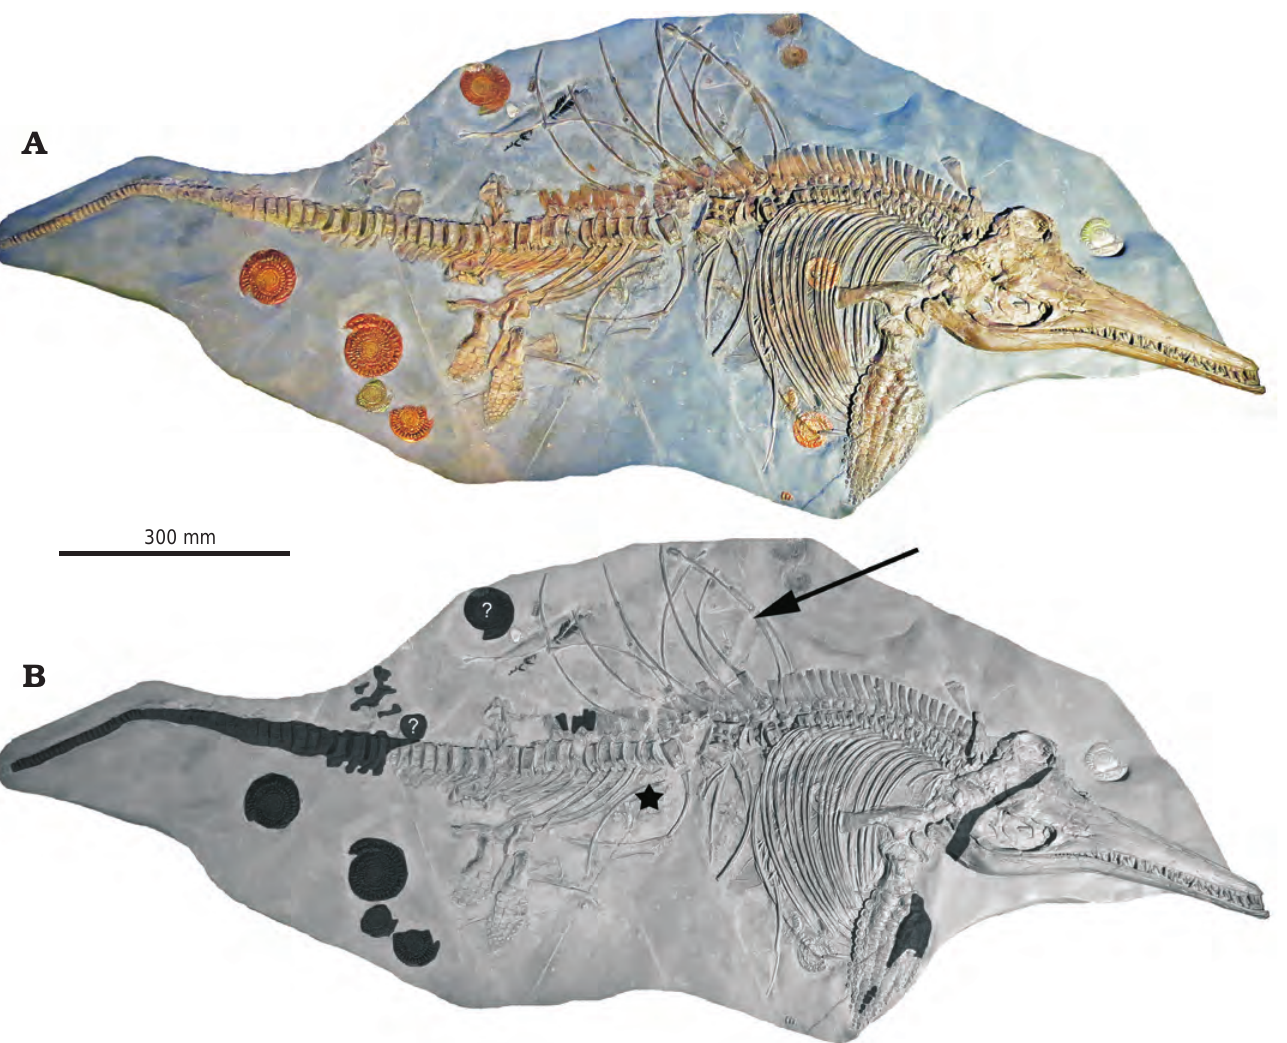
Fig. 2. A . Skeleton of Ichthyosaurus somersetensis Lomax and Massare, 2017 (NLMH 106234) from the Lower Jurassic (lower Hettangian) of Doniford Bay, Watchet, Somerset, UK. B . Explantory photograph with the composite/reconstructed sections shown in black; the question marks indicate that the element may have been added to the specimen; arrow points to a large crack that runs across the specimen; star indicates the position of the